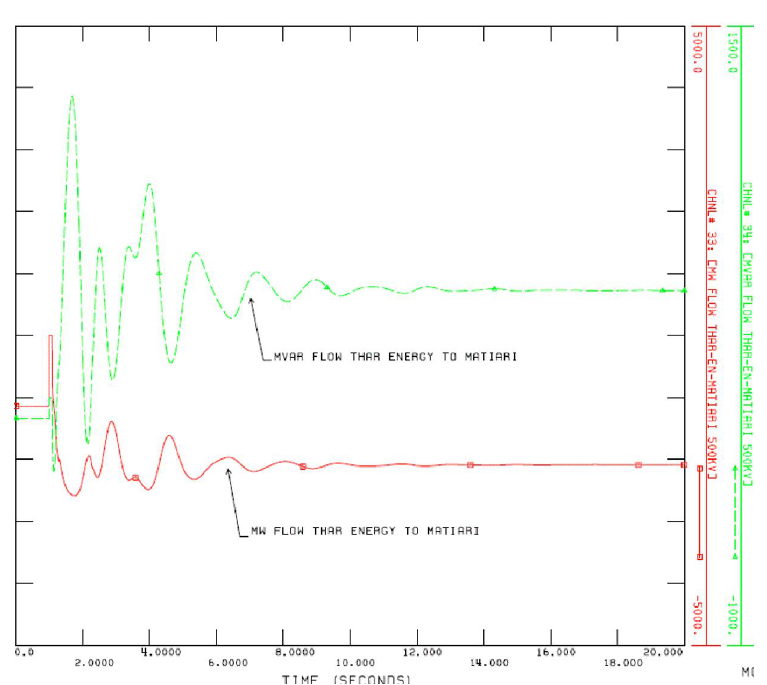
FIG. 13(c). RECOVERY OF MW AND MVAR FLOWS WITH TCSC